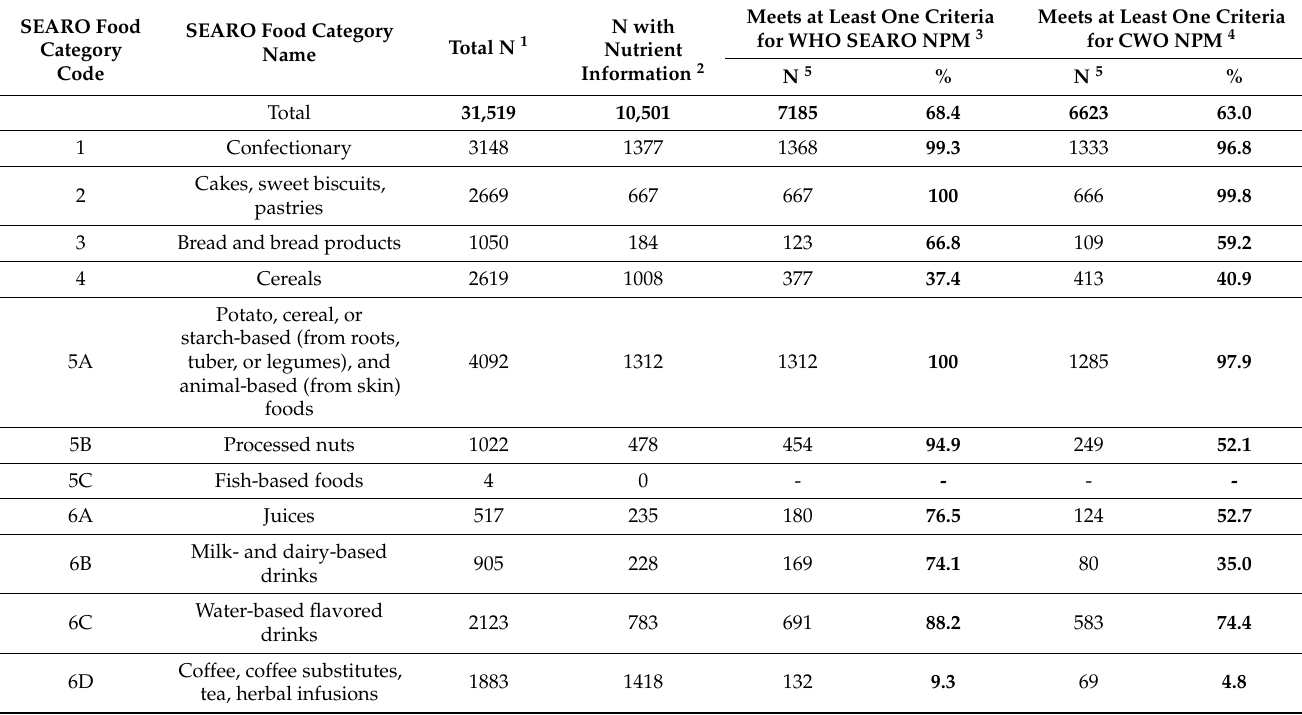
Table 1. The percentage of foods and beverages meeting the WHO South-East Asia Region Organization (SEARO) and Chilean Warning Octagon (CWO) nutrient profile modeling (NPM) criteria, by SEARO food category. SEARO Food Category